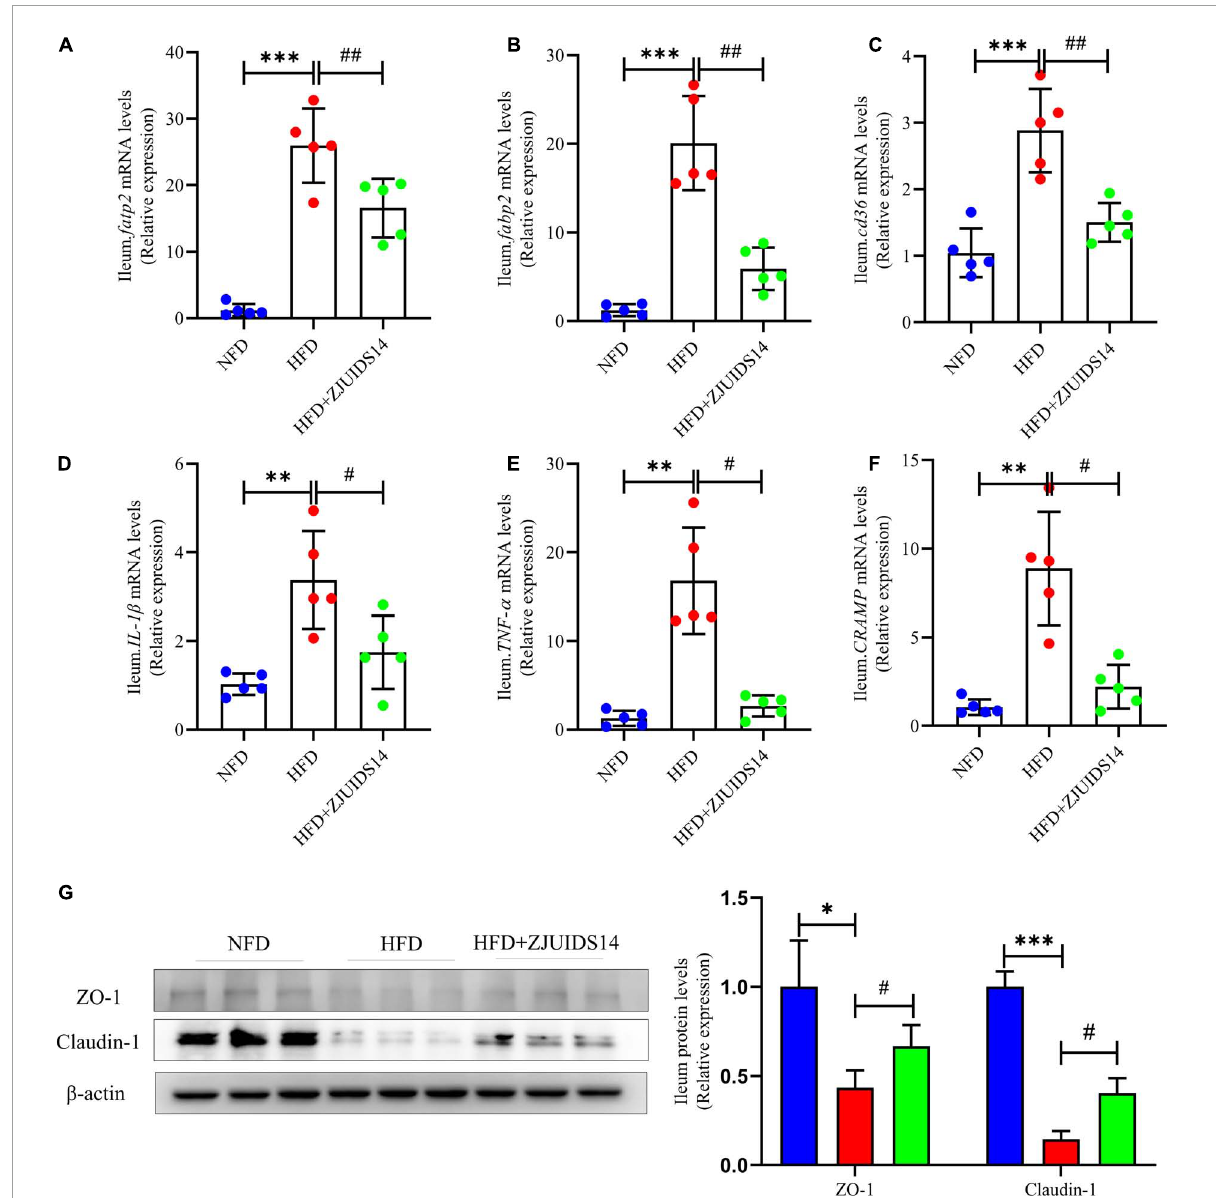
FIGURE6 Lactobacillus plantarum ZJUIDS14 administration mitigates ileum lipid metabolism and inflammation in HFD fed mice. Relative mRNA expression levels of (A) fatp2 ; (B) fabp2 ; (C) cd36 ; (D) IL-1 β ; (E) TNF- α ; and (F) cramp in ileum, protein levels of (G) ZO-1 and Clautin-1 in ileum. ∗ P < 0.05, ∗∗ P < 0.01, ∗∗∗ P < 0.001 vs NFD group; # P < 0.05, ## P < 0.01 vs HFD